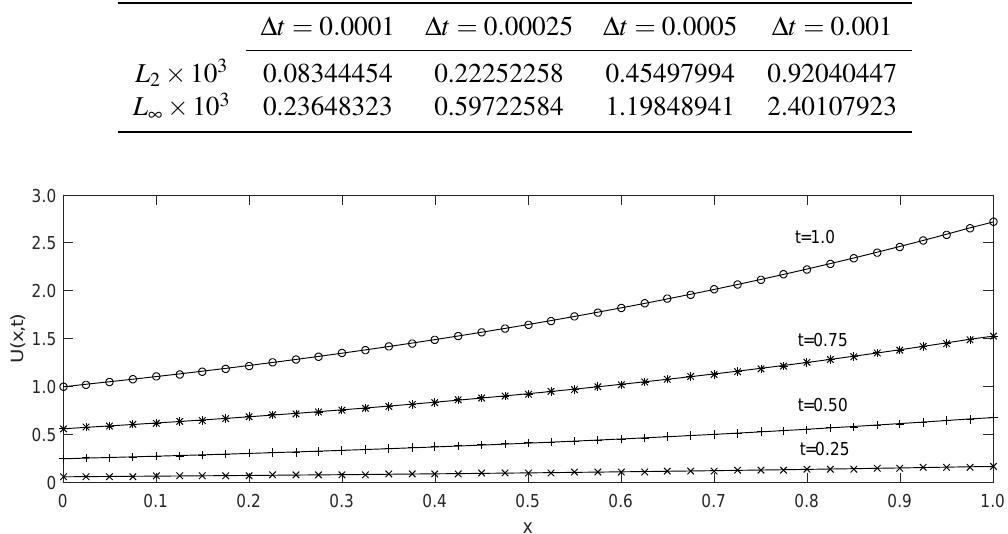
Table 7 Comparison of results at t f = 1 . 0 for ν = 1 , ∆ x = 0 . 025 and various time steps